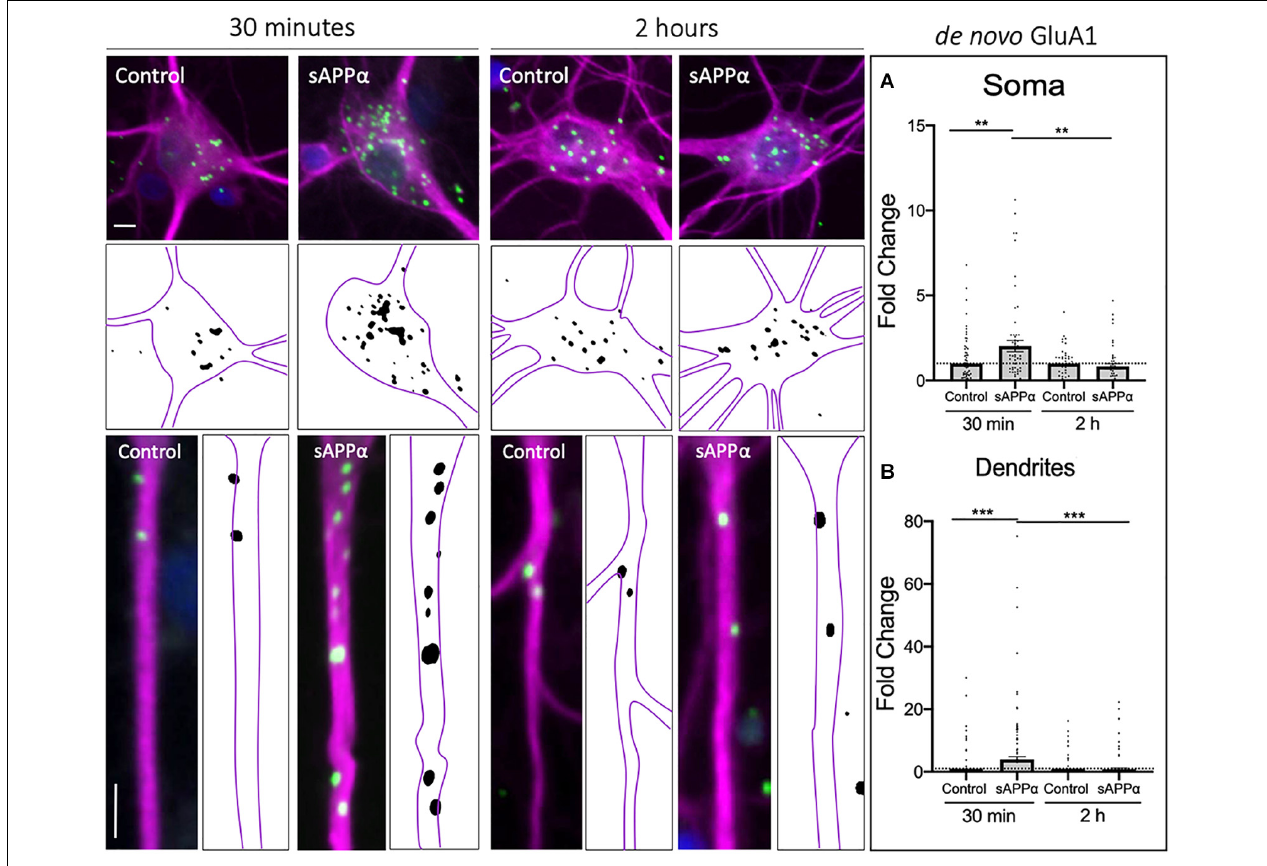
FIGURE 1 | Rapid increase in cell-surface de novo GluA1 following treatment. Representative images showing cell-surface de novo GluA1 levels in the soma (top panels) and dendrites (lower panels) from 30 min (left) and 2 h (right) control and sAPP α -treated conditions. (A) Average data showing 1 nM sAPP α promotes an increase in the soma ( n = 50–71 cells) following 30 min but not 2 h. (B) Average data showing 1 nM sAPP α (30 min) promotes an increase in de novo GluA1 at the dendritic cell surface follow 30 min but not 2 h treatments ( n = 104–128). Outliers were removed from each experiment prior to amalgamation using Grubb’s tests, and normality was detected by D’Agostino and Pearson omnibus normality tests. All data are expressed relative to control, as mean ± SEM from 3 experiments. Significance relative to control was assessed by student’s t -test, significance between sAPP α -treated groups was assessed by Mann-Whitney two-tailed U-test. ** p ≤ 0.01, *** p ≤ 0.001. Representative images show neuronal soma (upper panels) and dendrites (lower panels; MAP2, (cid:4) ; GluA1, (cid:4) ; DAPI, (cid:4) ). Scale bars = 10 µ